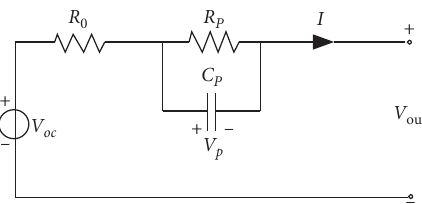
Figure 1: One-order